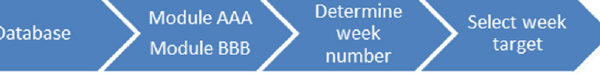
Fig. 3. Target week selection process